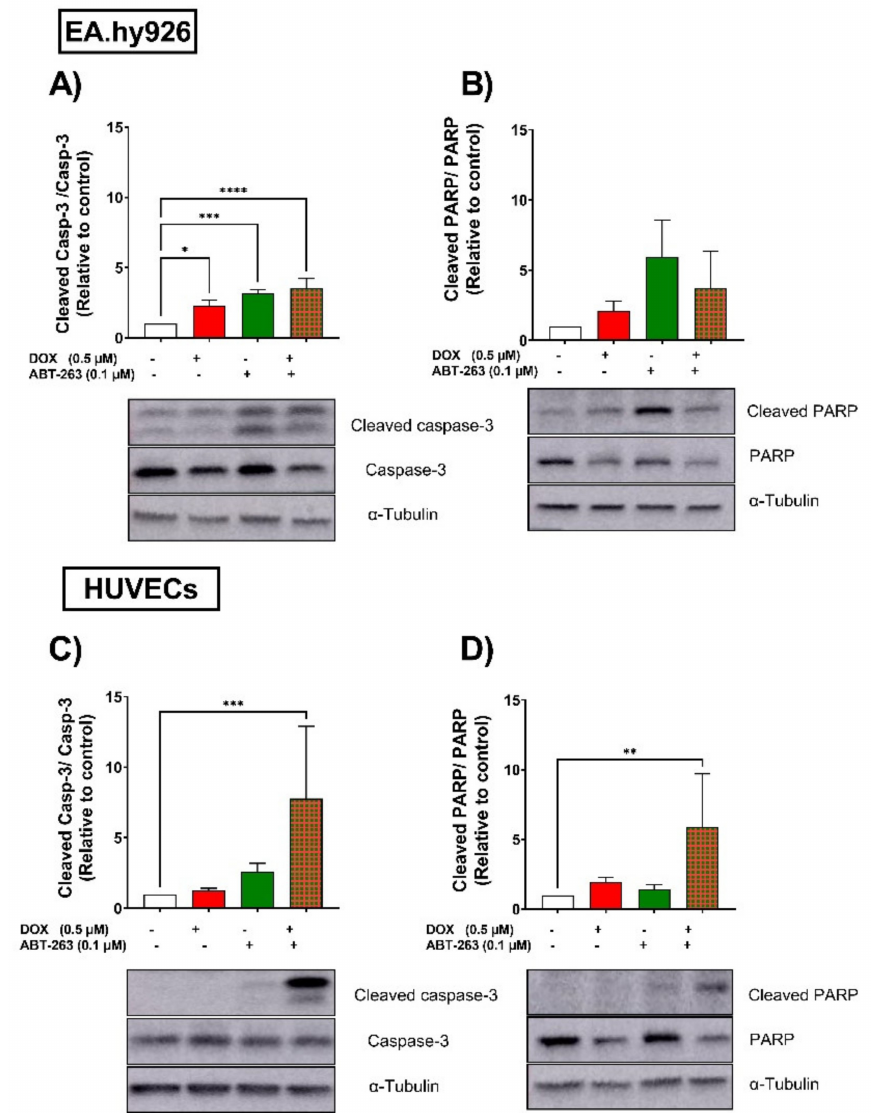
Figure 6. EA.hy926 and HUVEC cell lines respond differently to the senolytic drug ABT-263. Both EA.hy926 cells and HUVECs were treated with DOX (0.5 µ M) for 24 h or left untreated (control cells). Three days post DOX exposure, DOX-treated and control cells were treated with ABT-263 (0.1 µ M) for 6 h. Thereafter, expression levels of the apoptotic markers cleaved caspase-3 and cleaved PARP in EA.hy926 cells ( A , B , respectively) and HUVECs ( C , D , respectively) were measured via Western blotting ( n = 4–6). Values are presented as means ± SEM. Data were analyzed by one-way ANOVA followed by Dunnet’s multiple comparisons test. Note: * p < 0.05, ** p < 0.01, *** p < 0.001, **** p <